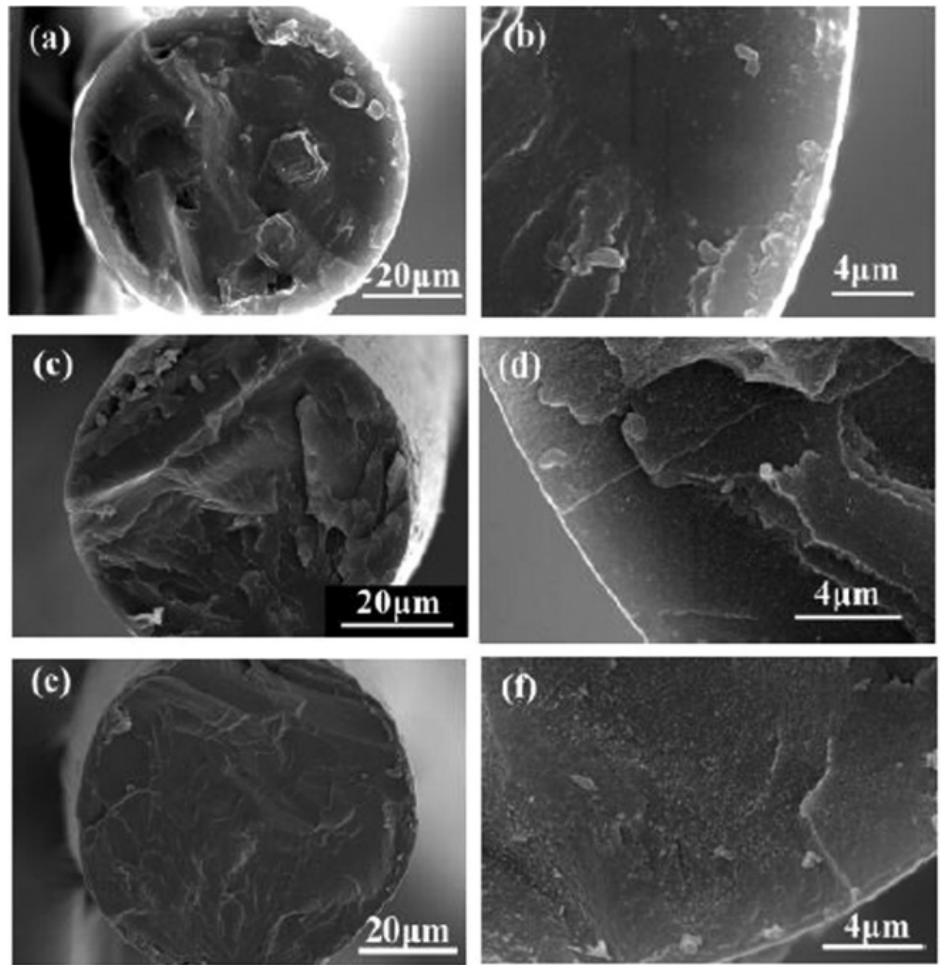
Figure 12. SEM micrographs of various as-spun PAN fibers containing different MWCNT contents (( a , b ): 0; ( c , d ): 0.5 wt%; ( e , f ): 1.0 wt%) (reprinted with permission from [110] , copyright 2011 John Wiley and Sons).